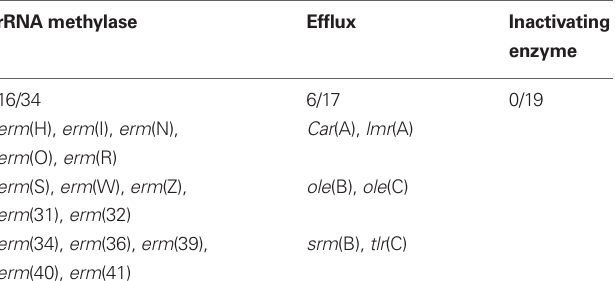
Table 3 | Macrolides, lincosamides, and streptogramins resistance genes unique to environmental bacteria.